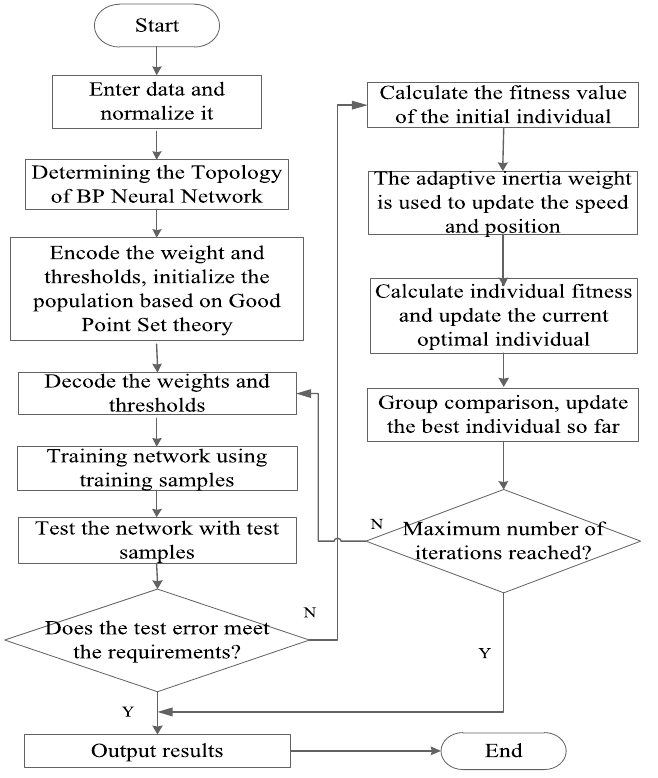
Figure 8. GPSAPSO-BPNN integrated algorithm flow chart.